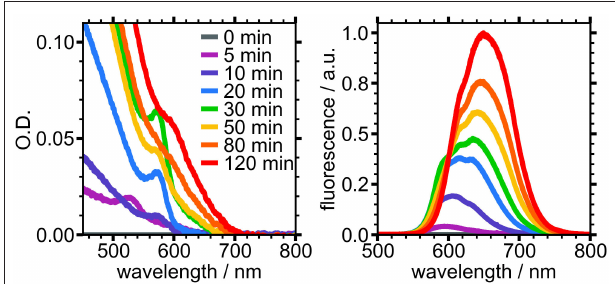
FIGURE 3 | Absorbance (Left) and fluorescence (Right) of PTFE-filtered reaction mixture sampled at different times during